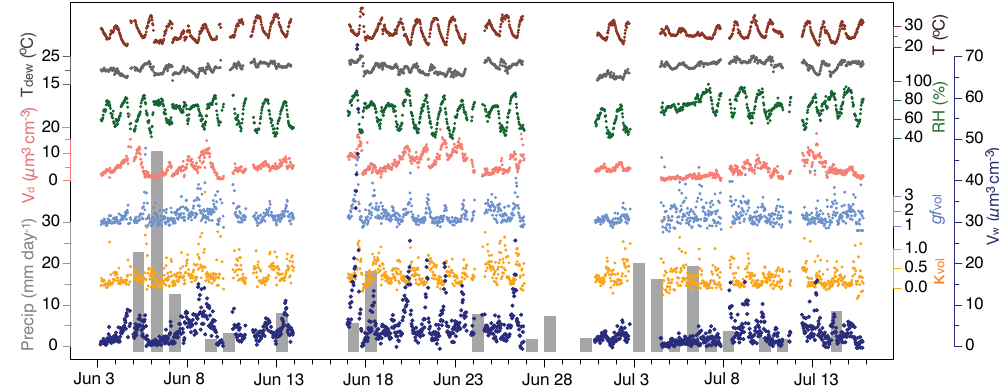
Figure 4. From top to bottom in foreground of figure: time series of (1) temperature ( T , ◦ C) in brown, (2) dew point temperature ( T dew , ◦ C) in dark grey, (3) relative humidity (RH, %) in green, (4) aerosol dry volume ( V d ,µm 3 cm − 3 ) in pink, (5) volumetric growth factor (gf vol , dimensionless) in light blue, (6) volumetric κ ( κ vol , dimensionless) in orange, and (7) particle-phase liquid water ( V w ,µm 3 cm − 3 ) in dark blue. Precipitation (Precip, mm day − 1 ) is shown in grey bars at the bottom of the plot. All of the data except for precipitation were recorded by the SMPS. Gaps in the data indicate periods when the instrument was not operating. Precipitation data are from the ARA SEARCH